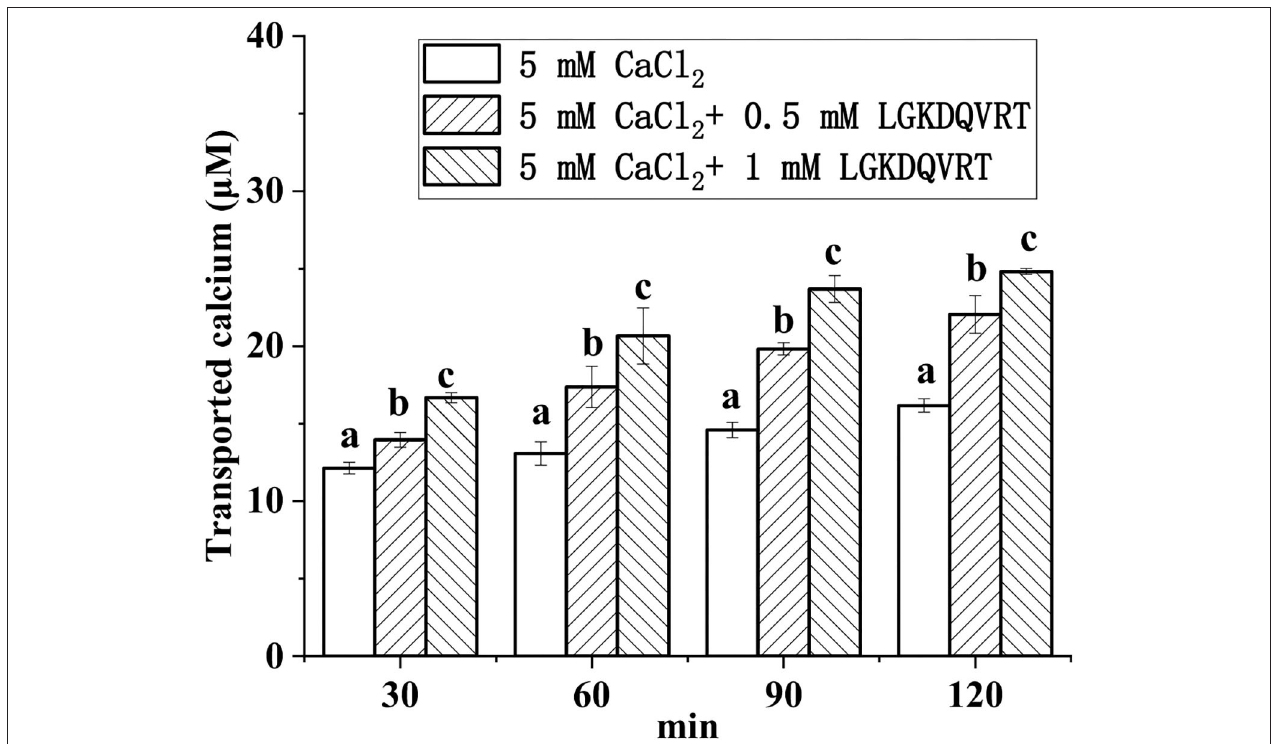
FIGURE 6 | Calcium transport studies. Different concentrations of the LGKDQVRT (0.5 and 1mM) or 5mM CaCl 2 in 0.5mL of Hank’s balanced salt solution (HBSS, pH 7.4) were added to the apical side, and incubated at 37 ◦ C for 2h. Aliquots were extracted from the basolateral side at 30, 60, 90, and 120min, and an equal volume of HBSS buffer was added to the basolateral side to keep the volume constant. Calcium contents were determined by using an atomic absorption spectrophotometer. Different letters indicate significant difference among the groups at the given time point ( p <